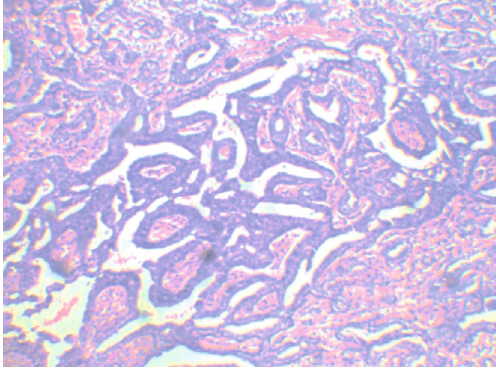
Figure 14: H and E sections showing arrangement of tumor cells in tubular pattern in the given tissue